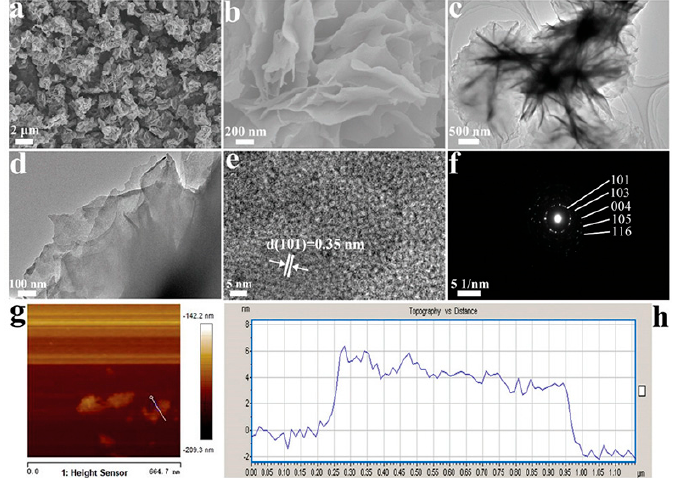
Figure 5. ( a , b ) SEM images, ( c , d ) TEM images, ( e ) HRTEM, ( f ) SAED pattern, ( g ) AFM topography image, and ( h ) the corresponding height information of the 2D ultrathin nanosheets. Reprinted with permission for ref. [83]. Copyright 2020, The Royal Society of Chemistry.